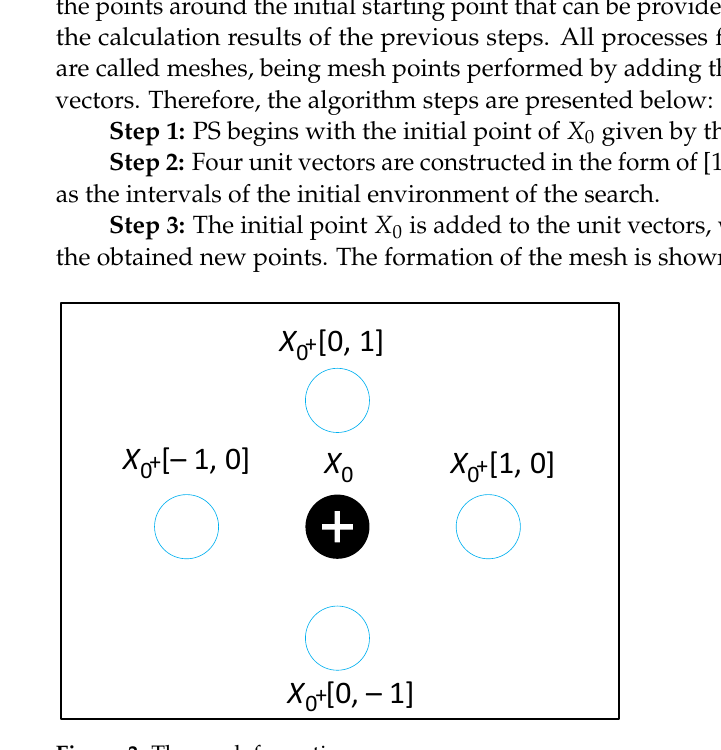
Figure 3. The mesh formation process.